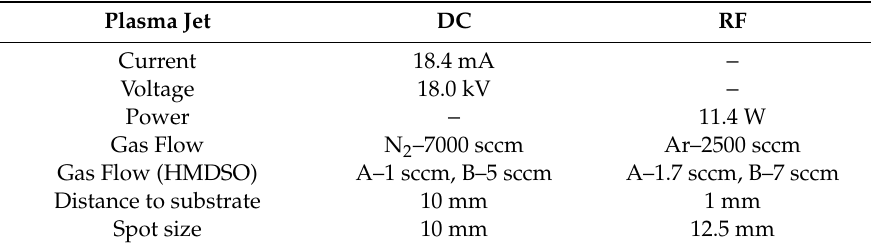
Table A3. Comparison morphologies of deposited coatings for DC and RF plasma